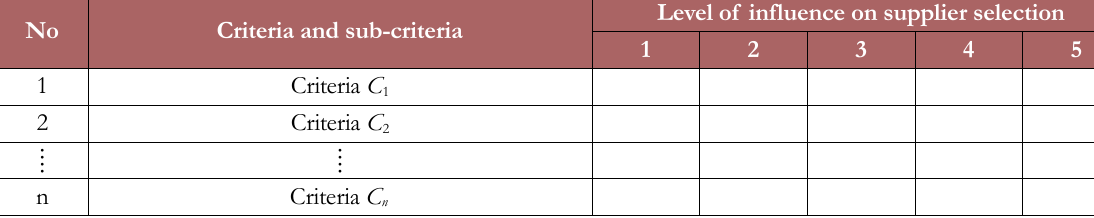
Table 2. Example of Questioner